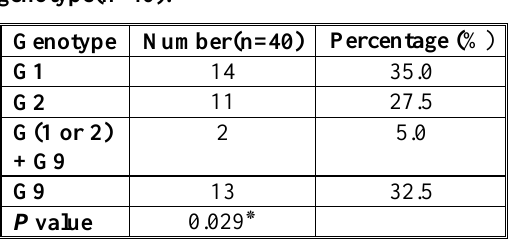
Figure 3.Rotavirus genotyping by nested multiplex PCR. ( lanes 1,7,10 and 12: G9 genotype , lanes 4 and 8: G1 genotype , lanes 2 and 9: G2 genotype , lane 3: mixed infection by G1 and G2 genotypes , lane 5: mixed infection by G1 and G9 genotypes , lane 11: mixed infection by G2 and G9 genotypes , lane 6: empty lane).